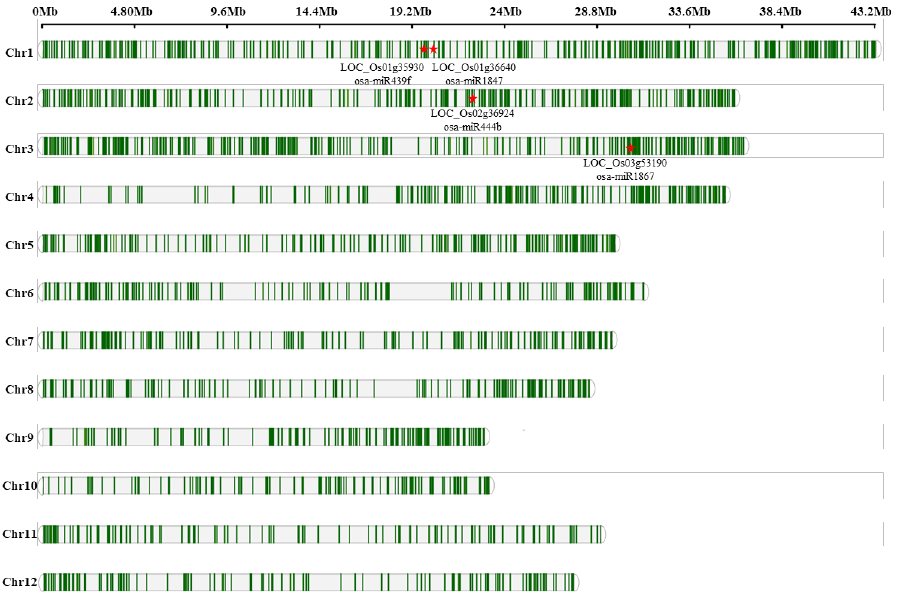
Figure 5. Distribution of RI-type AS events and the related intronic miRNAs in inferior spikelets of rice under CK and MD treatments. The location of the RI-type AS events with intronic miRNAs are indicated with red